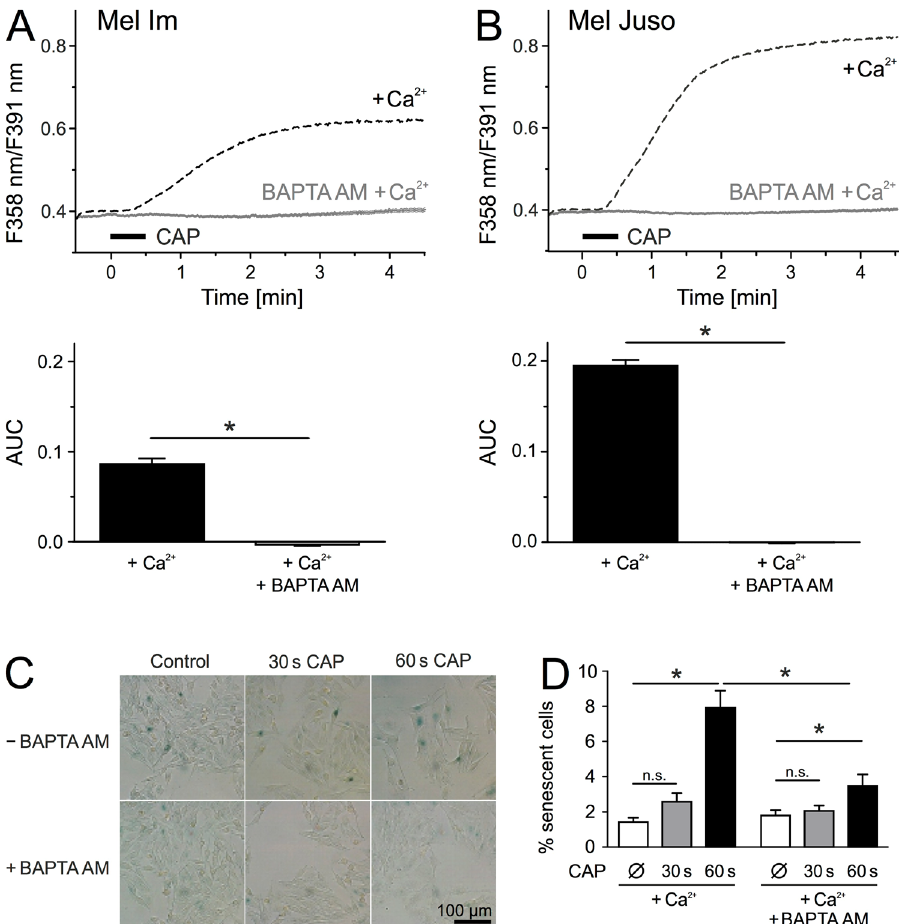
Figure 5. CAP-induced senescence and Ca 2 + influx are linked to each other. ( A,B ) Mel Im ( A , n = 389) and Mel Juso ( B , n = 660) were simultaneously loaded with the Ca 2 + chelator BAPTA AM (10 µ M) and fura-2 AM (3 µ M) and cytoplasmic Ca 2 + was measured during and after 30 s CAP exposure. ( C , D ) Senescence- associated ß-galactosidase staining of Mel Juso (n = 20, each from four independent runs) 48 h after CAP exposure for 30 s or 60 s and with or without BAPTA AM (10 µ M) pretreatment. ( C ) Representative pictures were taken with a 20 × magnification in bright field illumination. Senescent cells showed a blue staining due to senescence-associated ß-galactosidase activity. Traces are mean and 99% confidence interval ( A , B ) and bars are mean ± SEM ( D